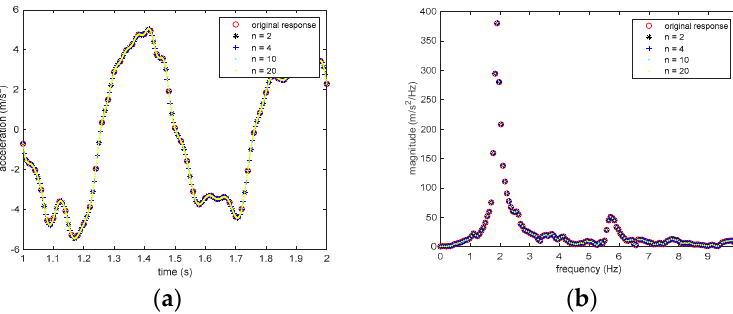
Figure 14. Comparison of original and upsampled structural response with different upsampling rates: ( a ) time domain response; ( b ) frequency domain response.